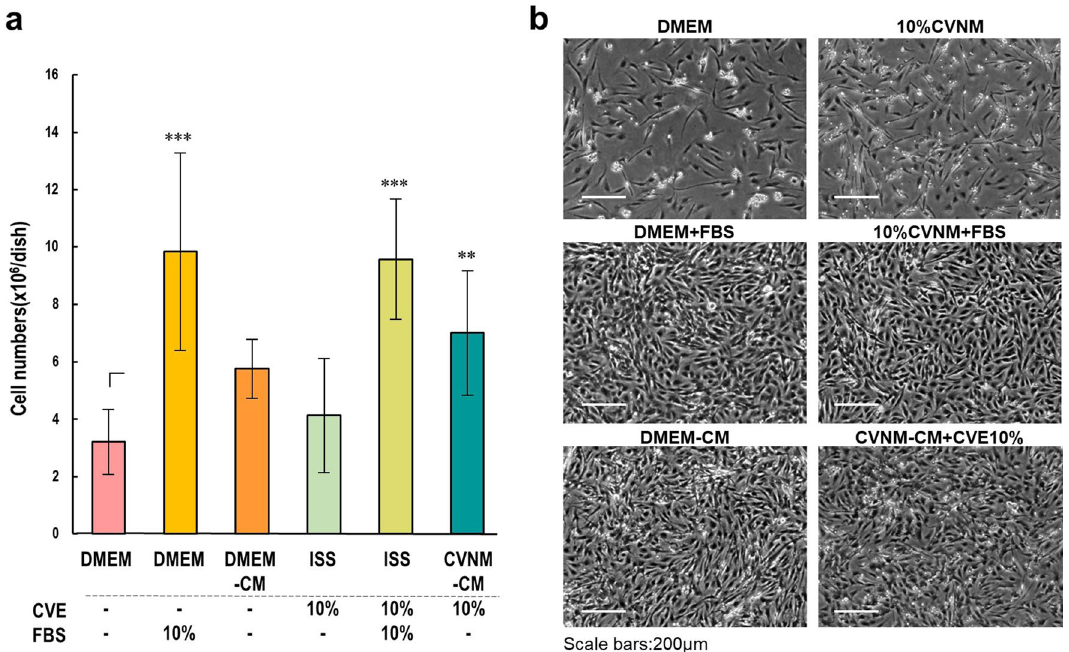
Figure 8. Scaling up of culture system ( a ) Cell numbers of primary bovine myoblasts cultured in 100 mm dish for 48 h. The following media were used: DMEM, DMEM with 10% FBS, DMEM-CM, ISS with 10% CVE, 10% CVNM with 10% FBS, and CVNM-CM with 10% CVE. Data are presented as the mean ± standard deviation (n = 5–7). *** P < 0.001, ** P < 0.01. ( b ) Images of primary bovine myoblasts under the different media conditions for 48 h. CVE, Chlorella vulgaris extract; CVNM, C. vulgaris -derived nutrient media; CVNM-CM, CVNM-based conditioned media; DMEM, Dulbecco’s modified Eagle’s medium; DMEM-CM,